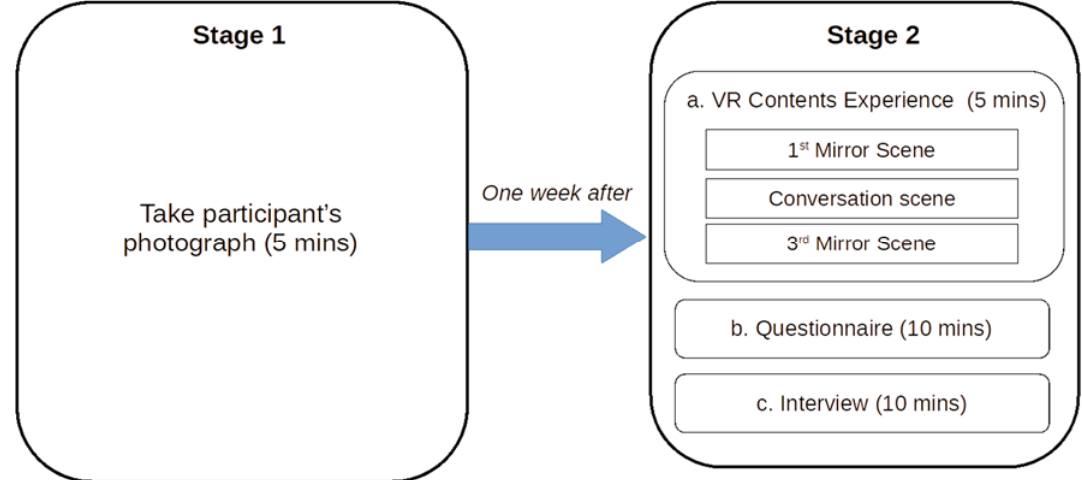
Figure 1. Experimental procedure.